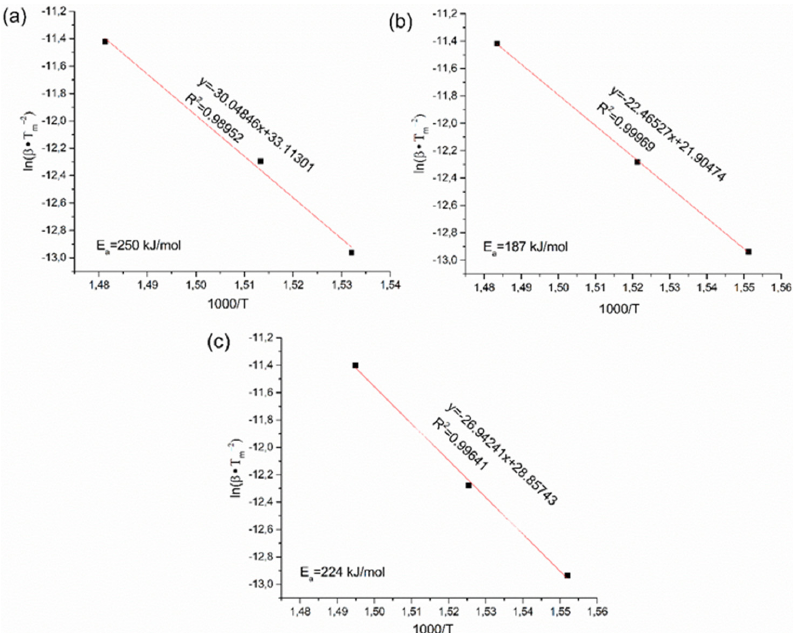
Figure 7. The activation energy of hydrogen decomposition for the AZ31 alloy modified by 4.0 wt.% Li ( a ), 7.5 wt.% Li ( b ) and 15.0 wt.% Li ( c Li ( a ), 7.5 wt.% Li ( b ) and 15.0 wt.% Li ( c ).